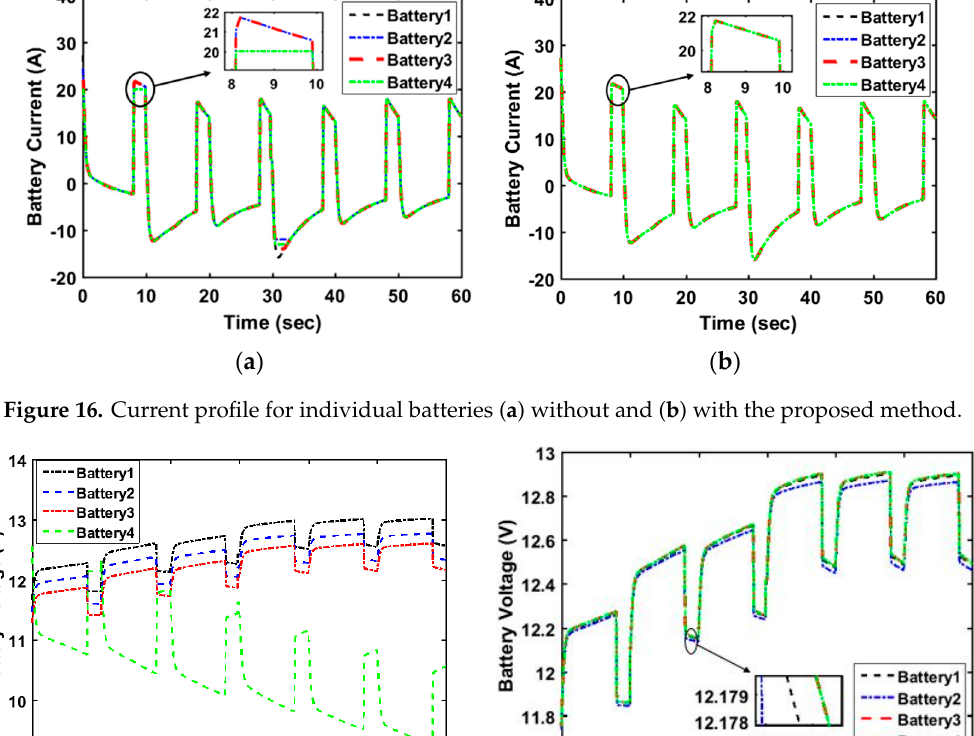
Figure 15. Overall battery bank voltage using conventional and the proposed method.